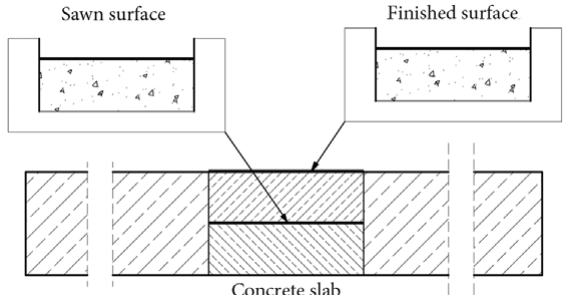
Fig. 4. Specimens prepared for the scaling resistance test Table 4. Properties of concrete mix